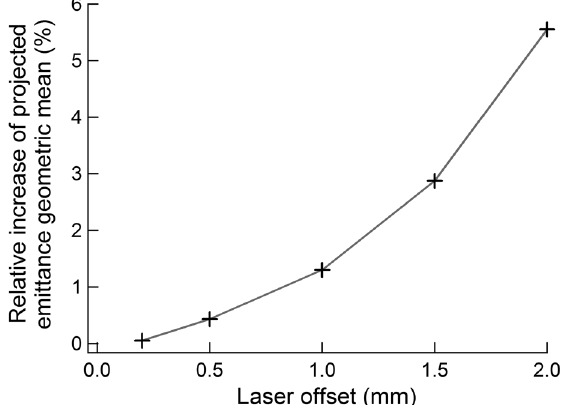
Table IV contains a list of the correctors ’ bending radii associated with this optimized solution. Different signs of the bending radius represent different bending directions. the beam is not centered along the beam line components.